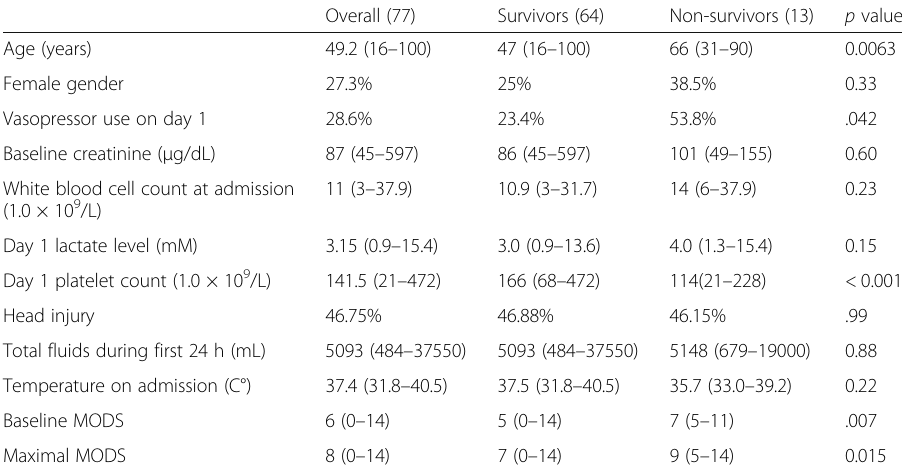
Table 1 Baseline characteristics of 77 trauma